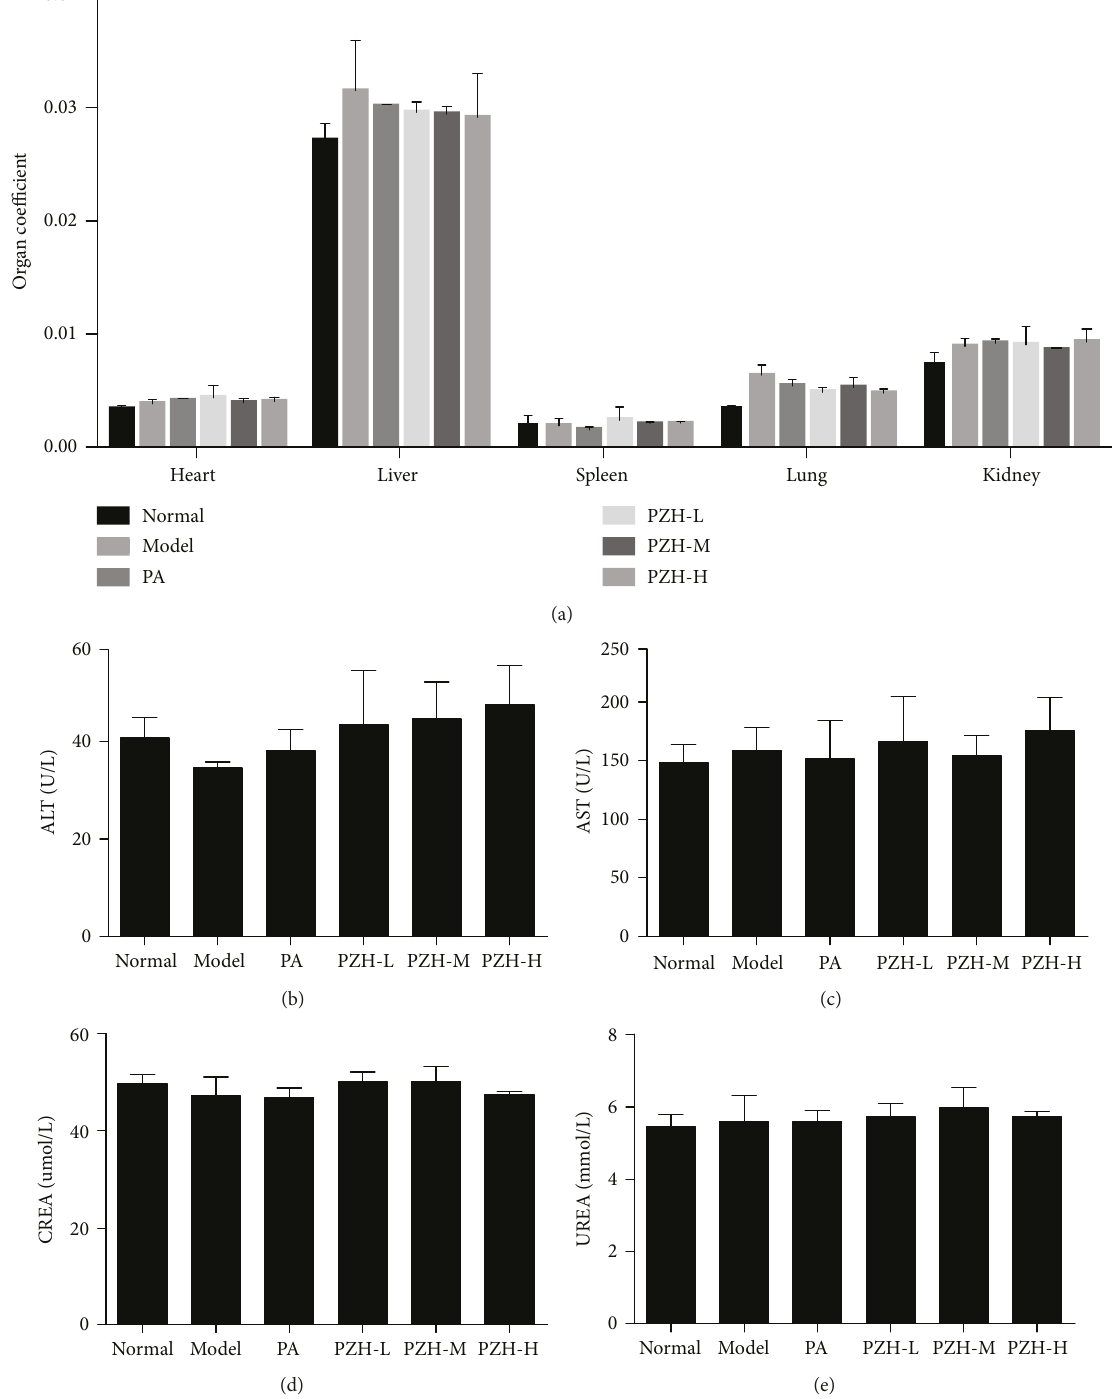
Figure 7: PZH has no signi fi cant toxicity in EAE rats. (a) The organ coe ffi cient of several organs from the respective group was detected. The levels of ALT (b) and AST (c) for hepatotoxicity as well as CREA (d) and UREA (e) for nephrotoxicity were shown,